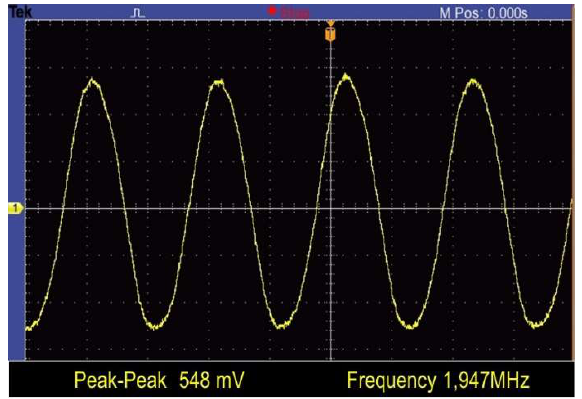
Figure 6. Time-domain oscillator output signal measured for V dc = 27 V.